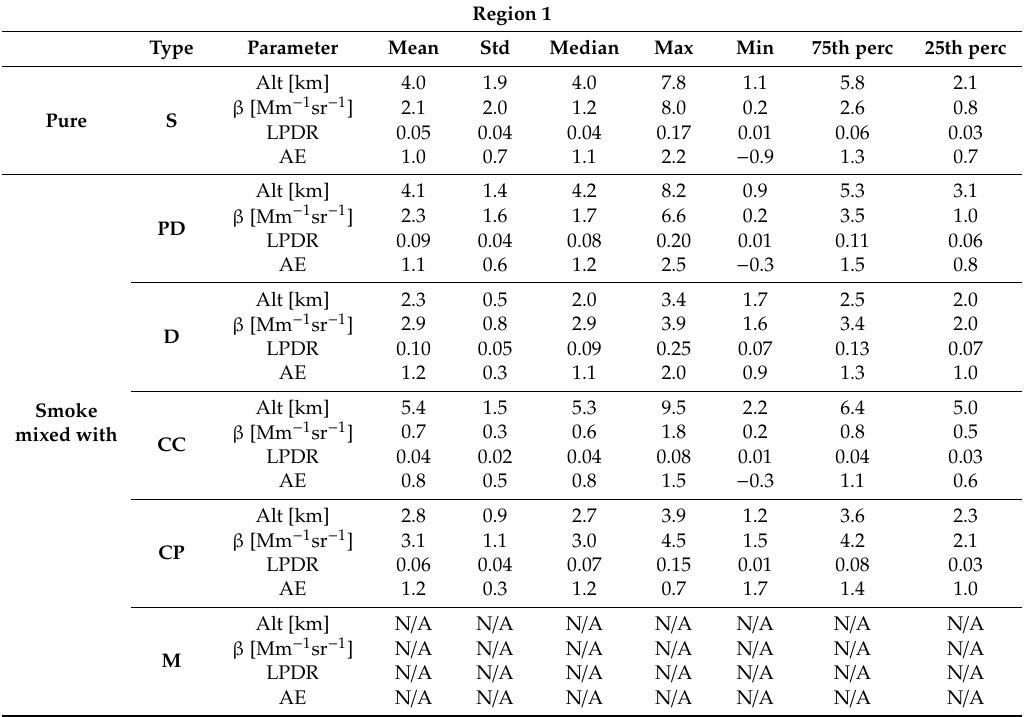
Table A1. Descriptive Statistics for di ff erent aerosol types for Region 1 (R1): mean, standard deviation (std), median, maximum value (max), minimum value (min), 75th and 25th percentile for all variables.